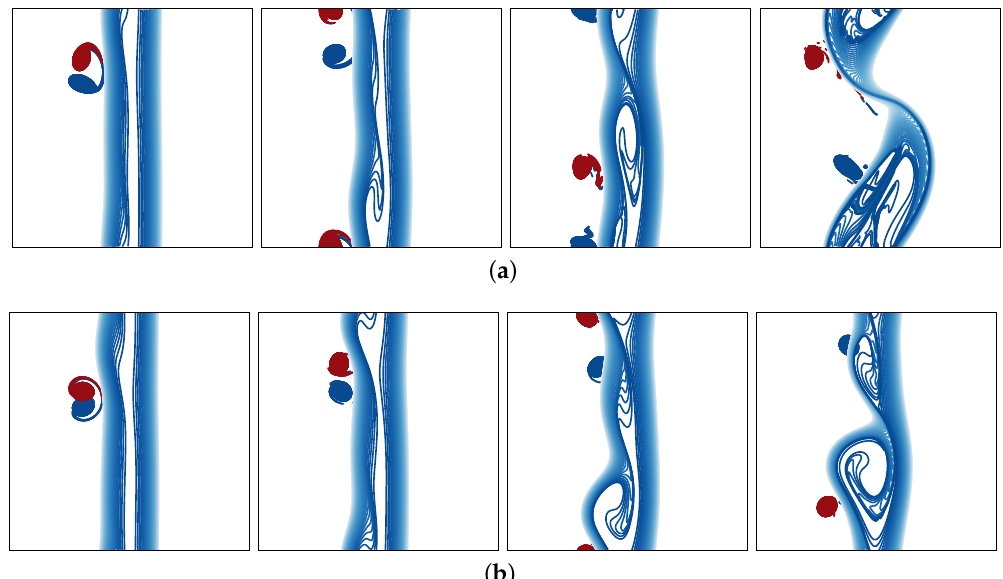
Figure 15. Cases 6.1 ( a ) and 6.2 ( b ): effect of tripling the filament half-width a from 0.25 to 0.75. The dimensionless horizontal shear remains Λ = 0.4 in case 6.1 while it is reduced by a factor of 3 in case 6.2, with all other parameters the same as in case 1. Top view of the flow showing contours of buoyancy and PV. In ( a ), the times shown are t = 6, 16, 24 and 32, while in ( b ), the times shown are t = 10, 16, 26 and 36.